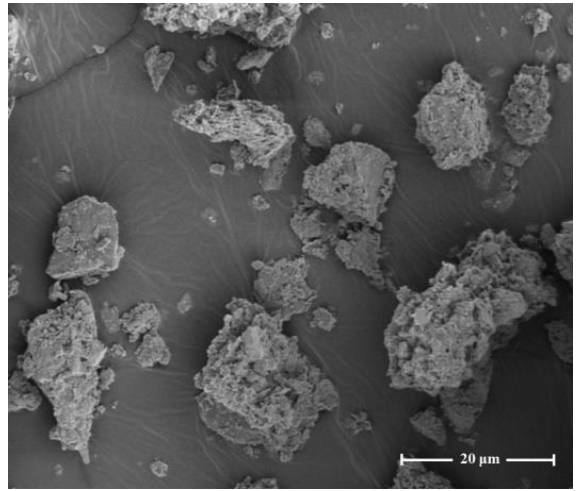
Figure 4. SEM microscopy of oily sludge.